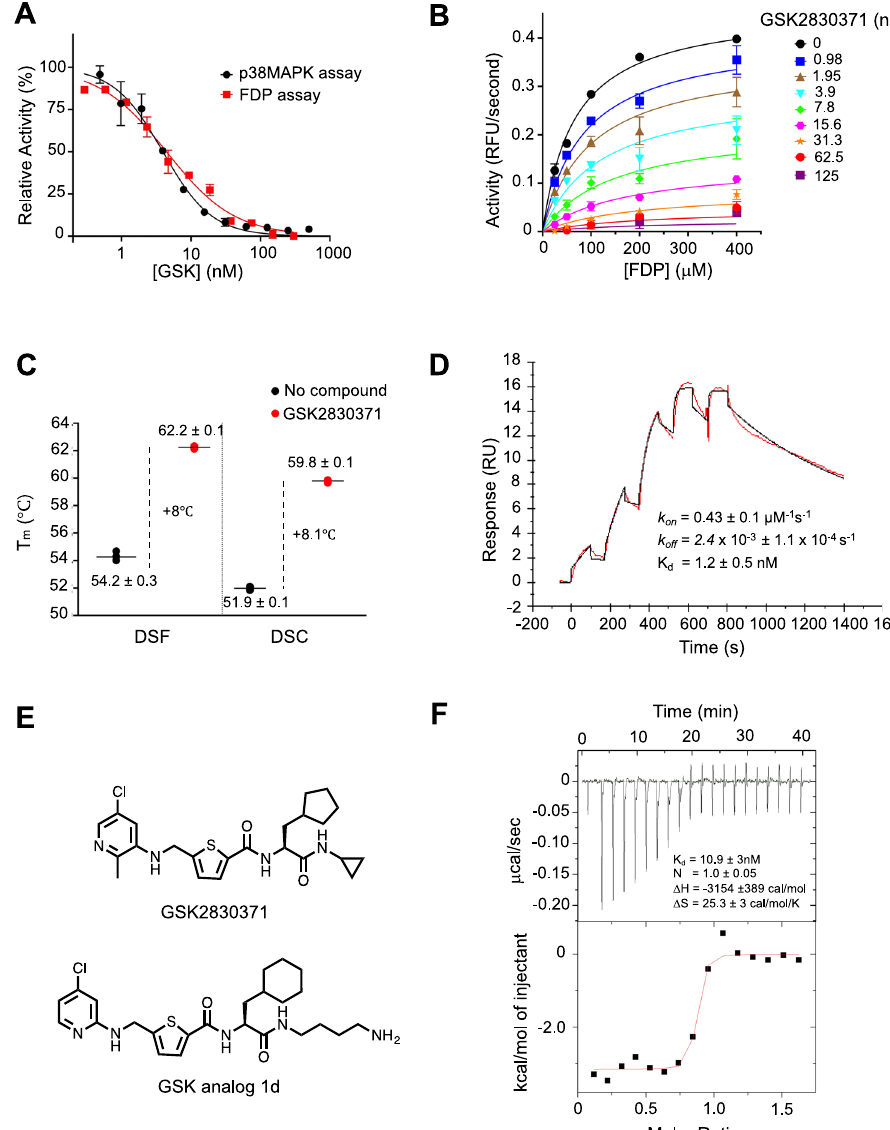
Fig. 3 GSK2830371 functions as a non-competitive inhibitor and binds with high af fi nity to PPM1D at an allosteric site. A Activity of GSK2830371 in the FDP (red) and p38 MAPK (black) enzymatic assays. FDP is cleaved by PPM1D in a substrate-independent fashion while p38 MAPK threonine 180 is dephosphorylated in a substrate-speci fi c manner. N = 3 independent samples runs. Data are presented as mean values ± SD. B Mechanism of